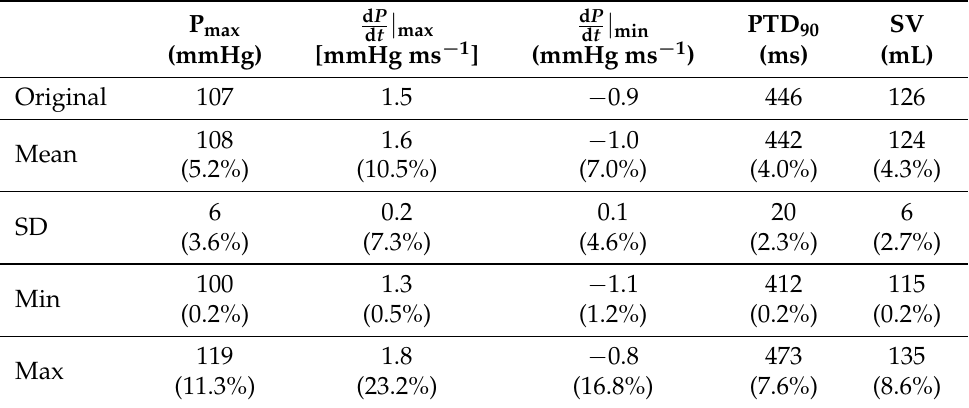
Table 6. Results of the clinical data uncertainty robustness analysis for the patient case 02-CoA. LV pressure and volume biomarker values of the second step of the active mechanics personalisation approach are given. The original values produced by the default initial guesses are listed in the first row and means (M), standard deviations (SD), minima (Min), and maxima (Max) of ten samples are listed in the subsequent rows. Means, standard deviations, minima, and maxima of the relative differences are given in brackets